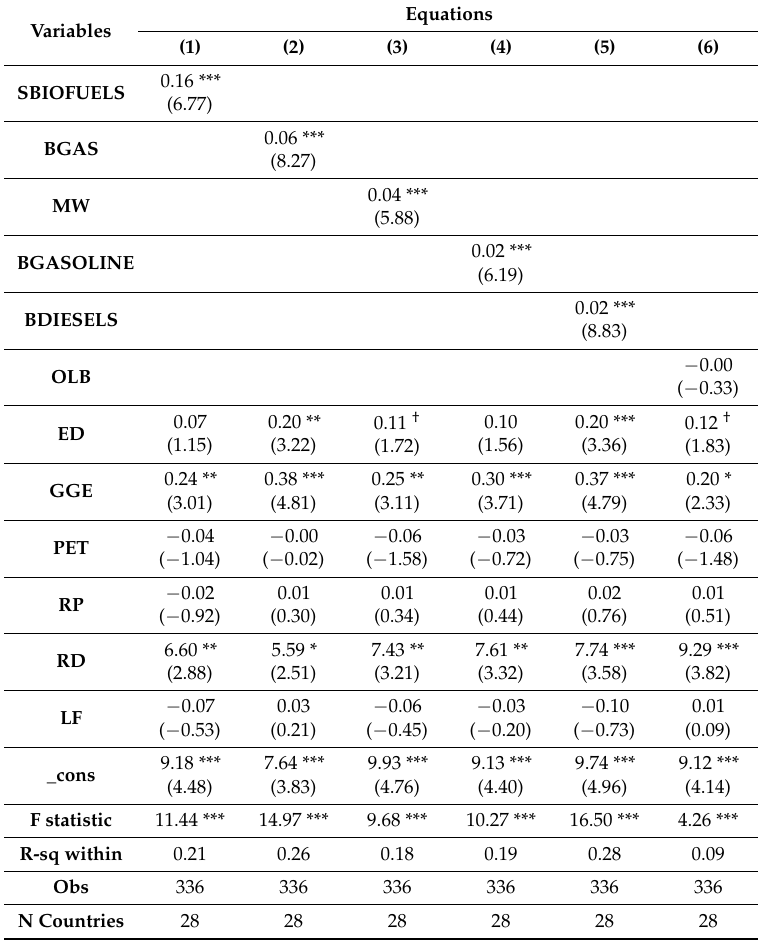
Table 7. Fixed-effects estimations towards the influence of biomass energy on sustainable economic